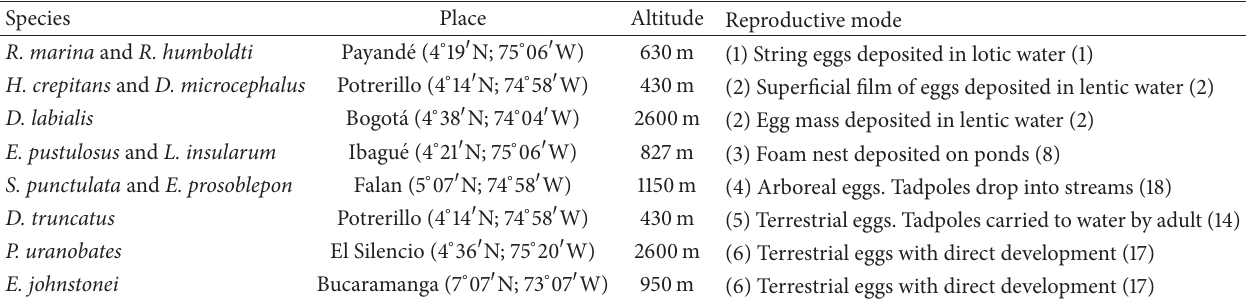
Table 1: Geographic localization and reproductive modes of the study species in Colombia. Categorizations of the reproductive modes, sensu Duellman and Trueb [2], are indicated in parentheses on the right